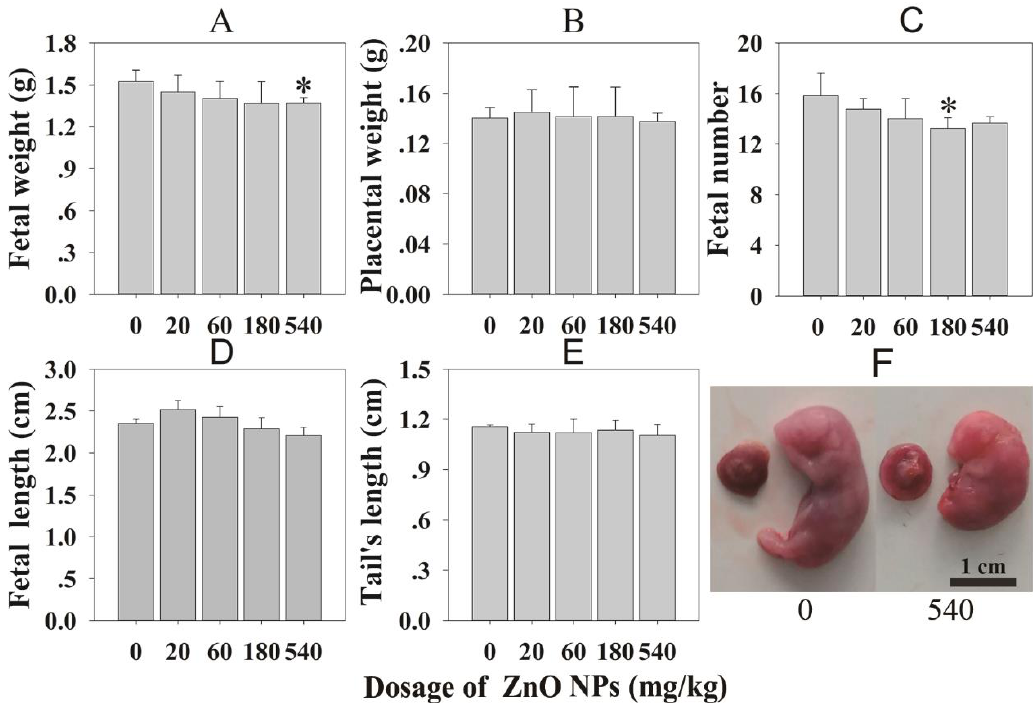
Figure 2. Fetal development status after maternal oral exposure to ZnO NPs. ( A ) Fetal weight; ( B ) placental weight; ( C ) fetal number; ( D ) fetal length; ( E ) tail’s length; ( F ) fetal image. All the data are expressed as the mean ± SD (n = 60). *P < 0.05 vs. control.